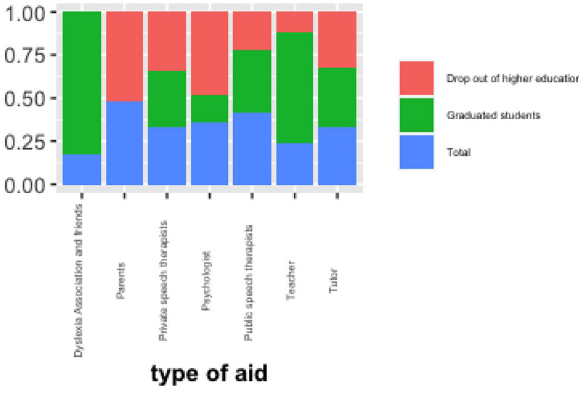
Figure 4. type of support used by type of student.